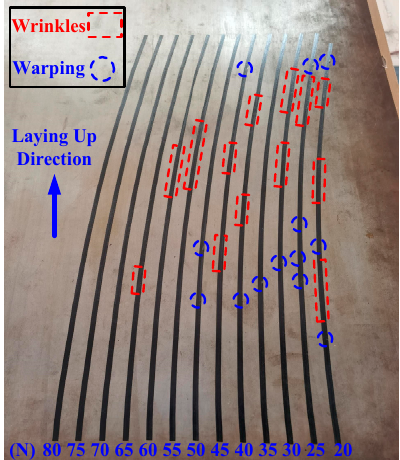
Figure 15. Results of experiment with different compaction forces.